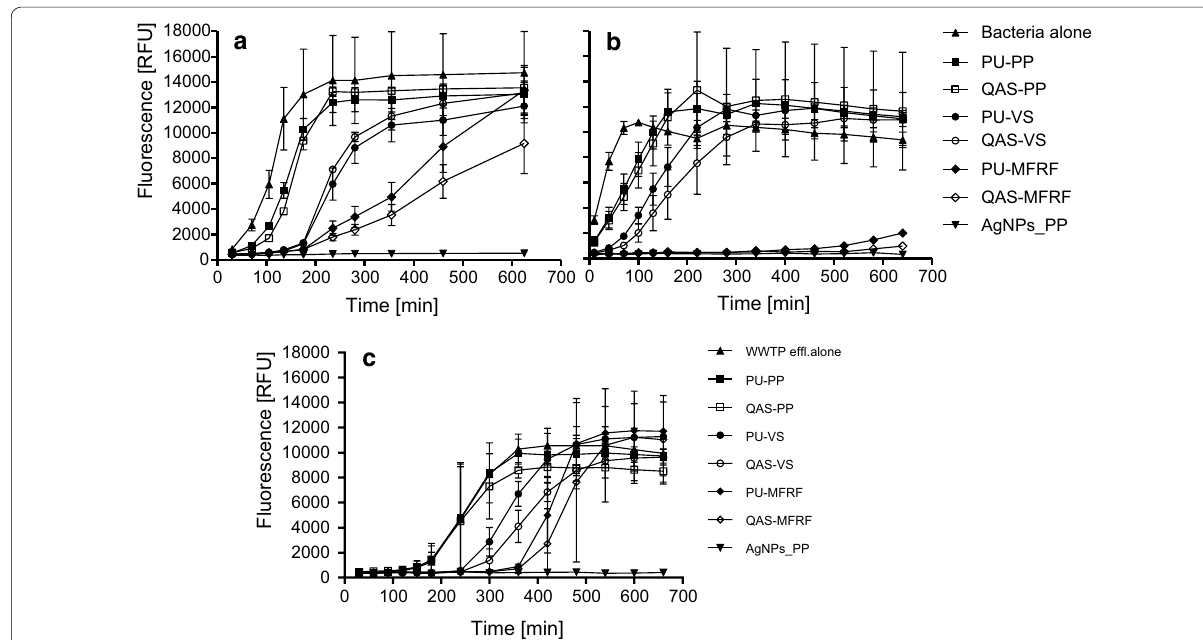
Fig. 4 Resazurin metabolization curves for E. coli ( a ), E. faecalis ( b ), and WWTP effluent ( c ) incubated with various membranes on PP, VS and MFRF supporting layers. Terms “Bacteria alone” and “WWTP effl. alone” mean pure inoculum incubated without a membrane. Values represent the mean SD of triplicate determinations. This figure shows a set of results of one experimental run as an example of three analogous independent ± experiments for either E. coli , E. faecalis or WWTP